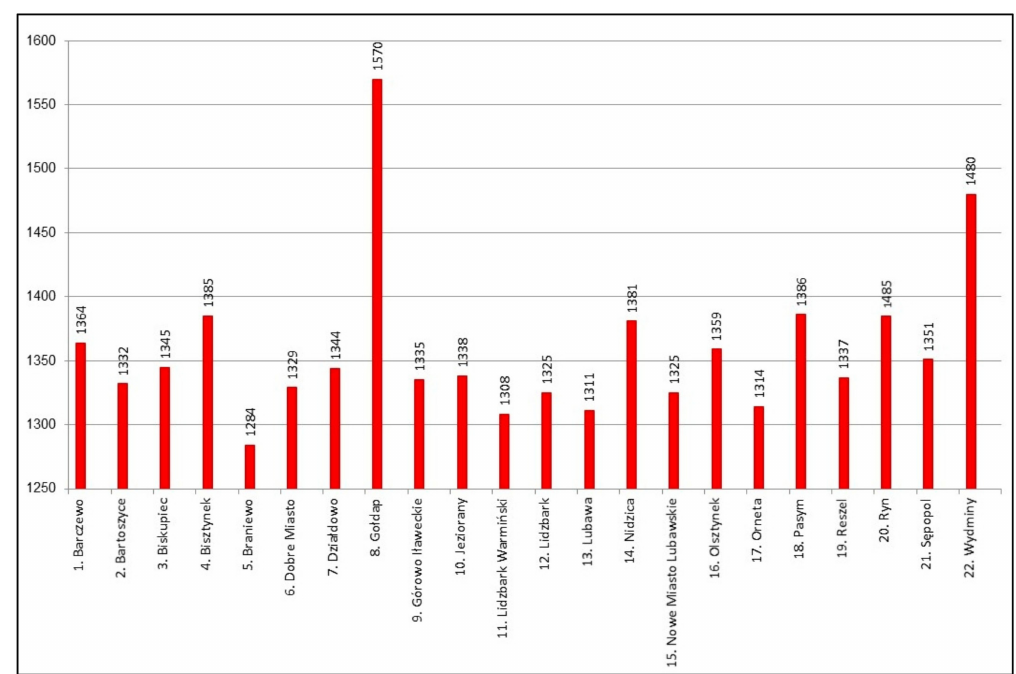
Figure 4. Founding dates of Polish towns. Source: own elaboration based on Czubiel and Domagała [47].